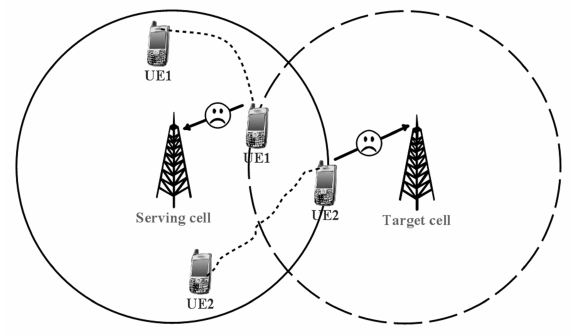
Figure 8. UE1 started the HO too early. UE2 started the HO too